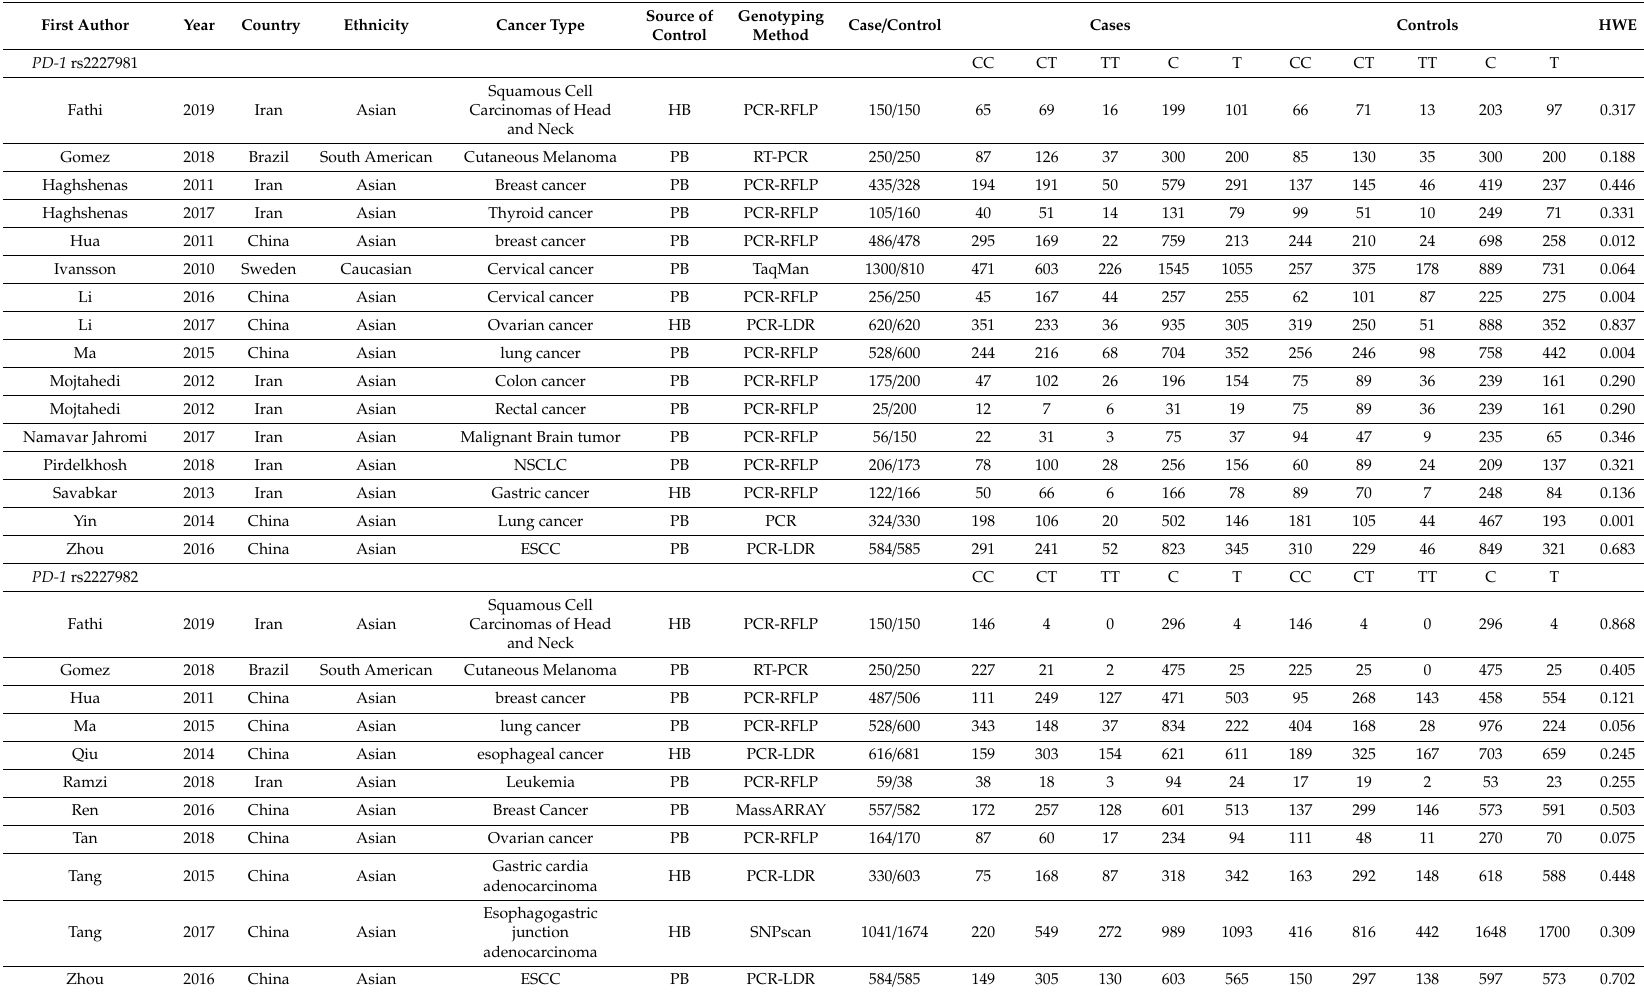
Table 2. Characteristics of the studies eligible for